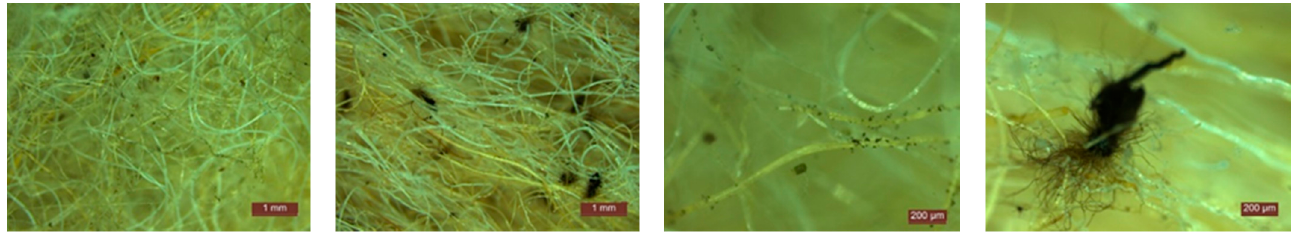
Figure 4. Image captures obtained by microscopic analysis of test specimens for mould resistance. Biological resistance to attack by worms and insects has highlighted an advantage of these thermal insulation materials compared with similar thermal insulation made exclu- sively or mainly of sheep wool: visual and, subsequently, microscopic analysis (Figure 5) tested do not represent a viable environment for moths ( Order lepidoptera ), their eggs and laying for the further life cycle. In the case of samples on which moth eggs and larvae